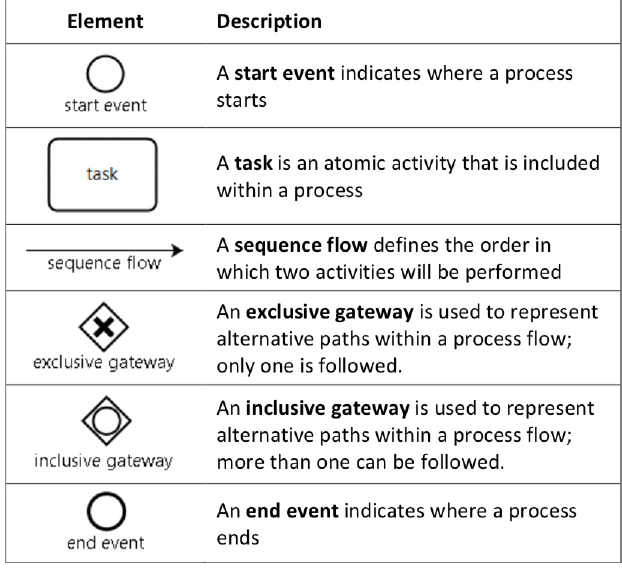
Figure 1. Basic elements of business process model and notation